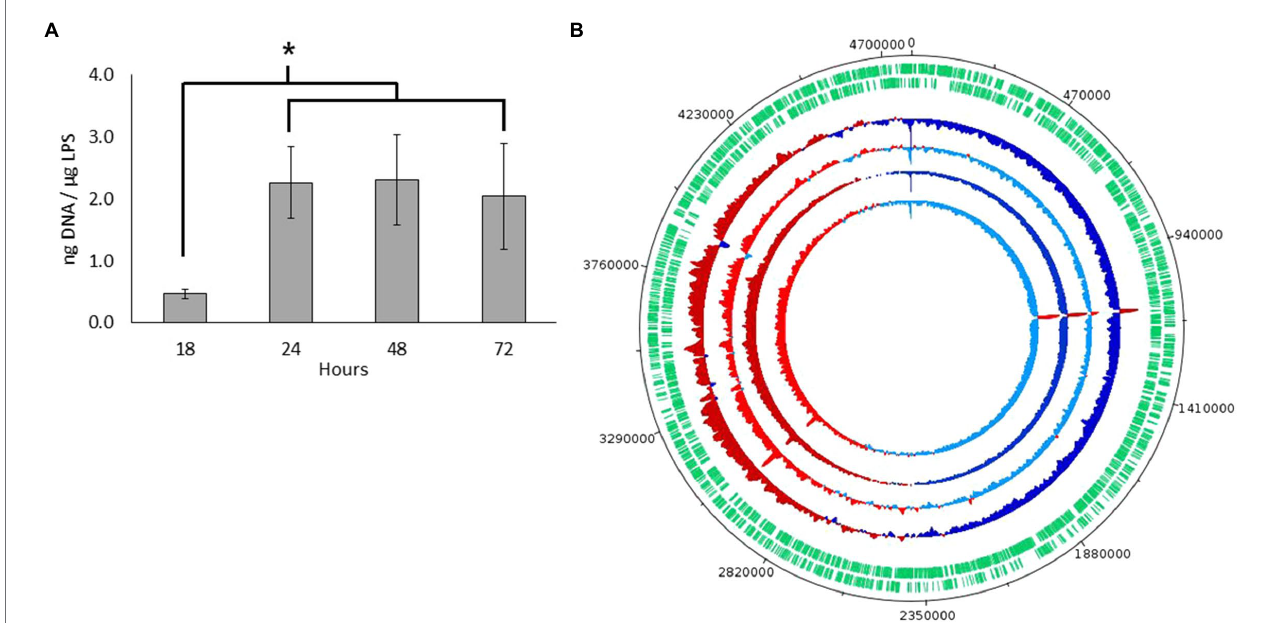
FIGURE 4 | DNA characterization from S. vesiculosa M7 T MVs. (A) DNA concentration from S. vesiculosa M7 T MVs at different times of growth. n = 3, ANOVA test, * p < 0.05. (B) Circos plot for the MVs-DNA read count across each replicates show read counts at each base pair position. Positions that show greater than average read density are colored in red, and those with less than average density are colored in blue. Darker tones show fractions of fragments larger than 125 bp, and lighter ones show fractions of fragments smaller than 125